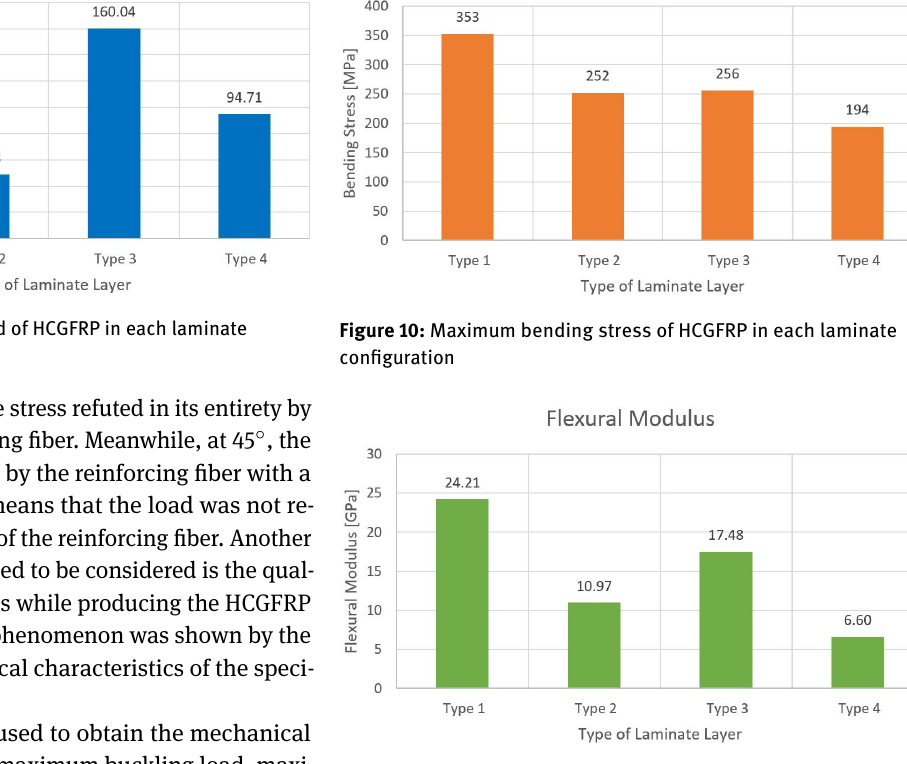
Figure 11: Flexural modulus of HCGFRP in each lamina